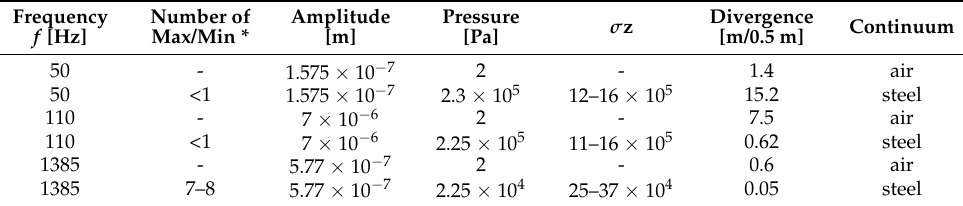
Table 2. Vibration amplitudes in air and steel for a constant sound pressure of 2